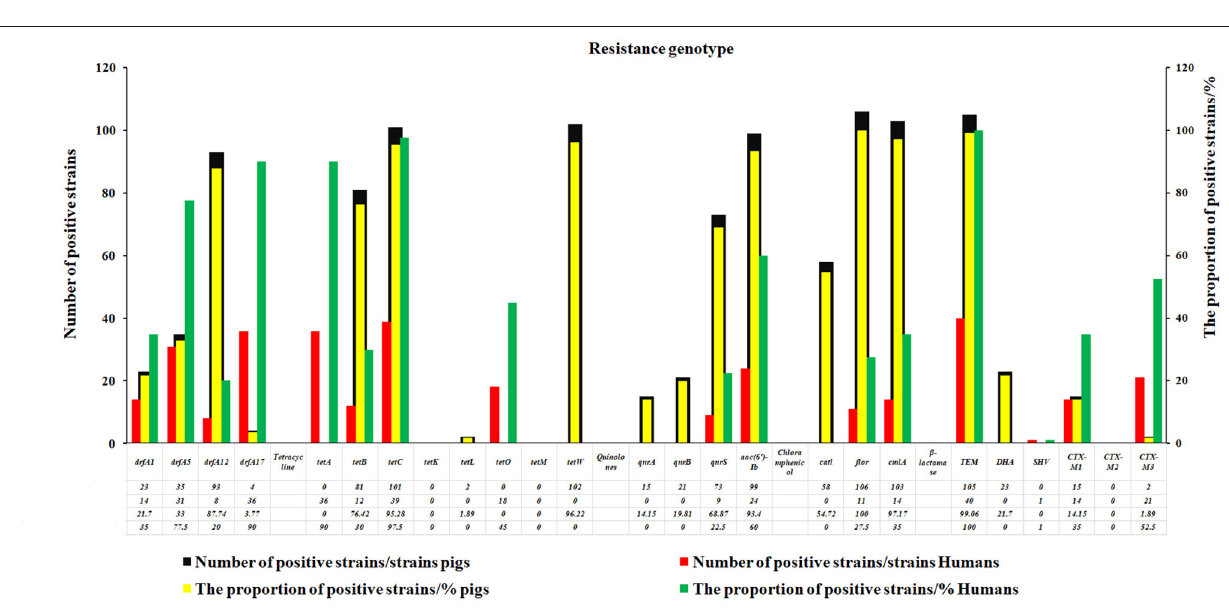
urine ST10 (1), sputum ST617 (1), and blood ST617 (1), sputum ST6896 (1), blood ST5296 (1), and urine ST710 (1), respectively. Two ST393 from the urine and blood each belonging to